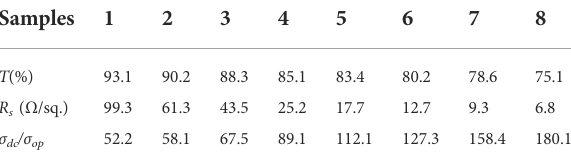
TABLE 1 Optoelectrical properties of the AgNWs/Ti 3 C 2 T x -FG/PVA fi lms.